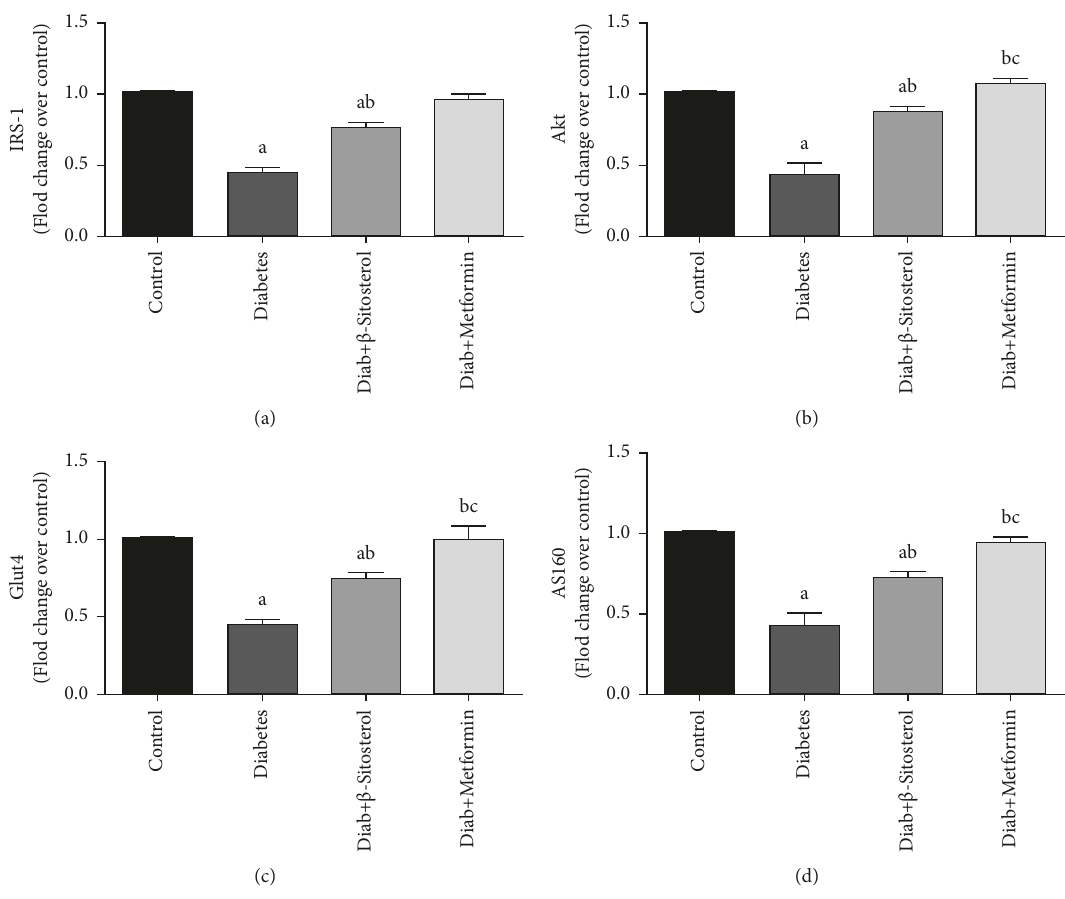
Figure 5: (a–d): The outcome of β -sitosterol on the mRNA expressions of IRS-1, Akt, GLUT4, and AS160 in diet-fed diabetic male rats was investigated using real-time PCR. The mean ± SEM of 6 distinct animals is represented by each bar as designated as follows: a–control; b—diabetic control; c— β -sitosterol-treated diabetic group, with a significance at p < 0 . 05. (a) IRS-1 mRNA. (b) Akt mRNA. (c) Glut4 mRNA. (d) AS160 mRNA.